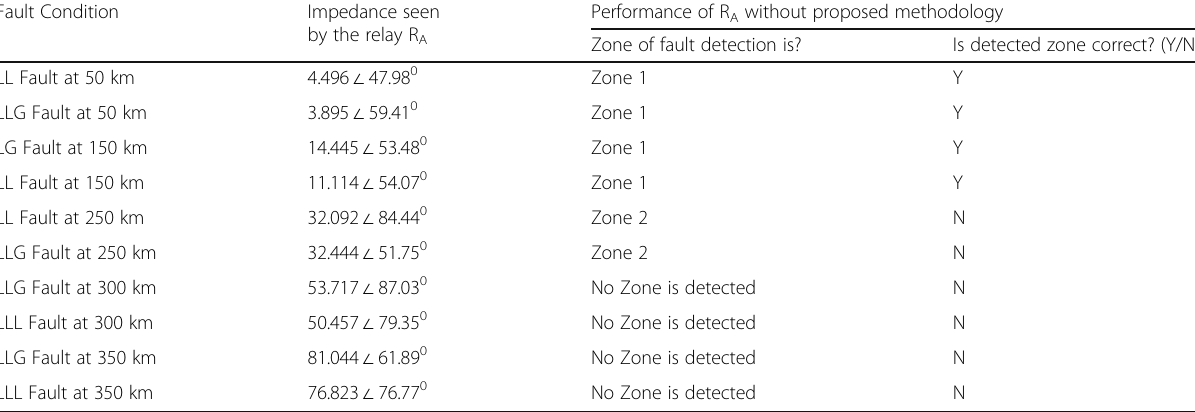
Table 5 Performance of distance relay R A without PAZSD methodology for different faults with FR = 1.7 Ω at different distances Fault Condition Impedance seen Performance of R A without proposed by the relay R A